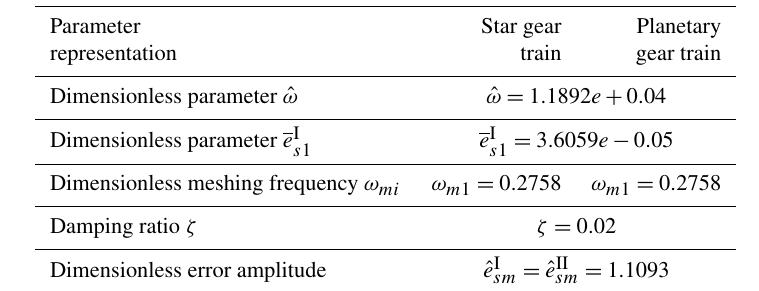
Table 2. Dimensionless